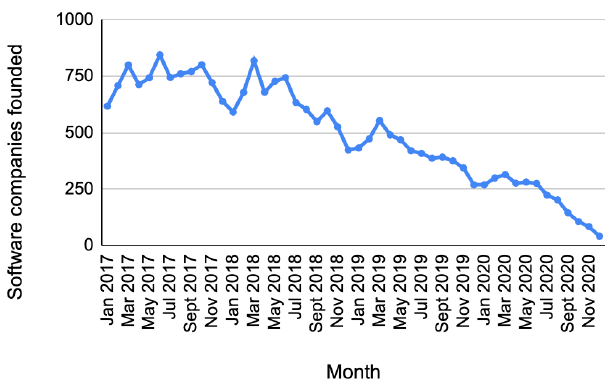
Figure 4: Companies categorised under 'software' founded